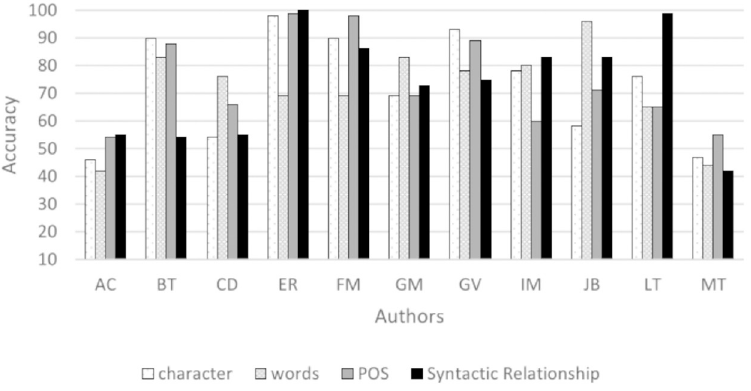
Fig 4. Average accuracy (%) for 3-grams using